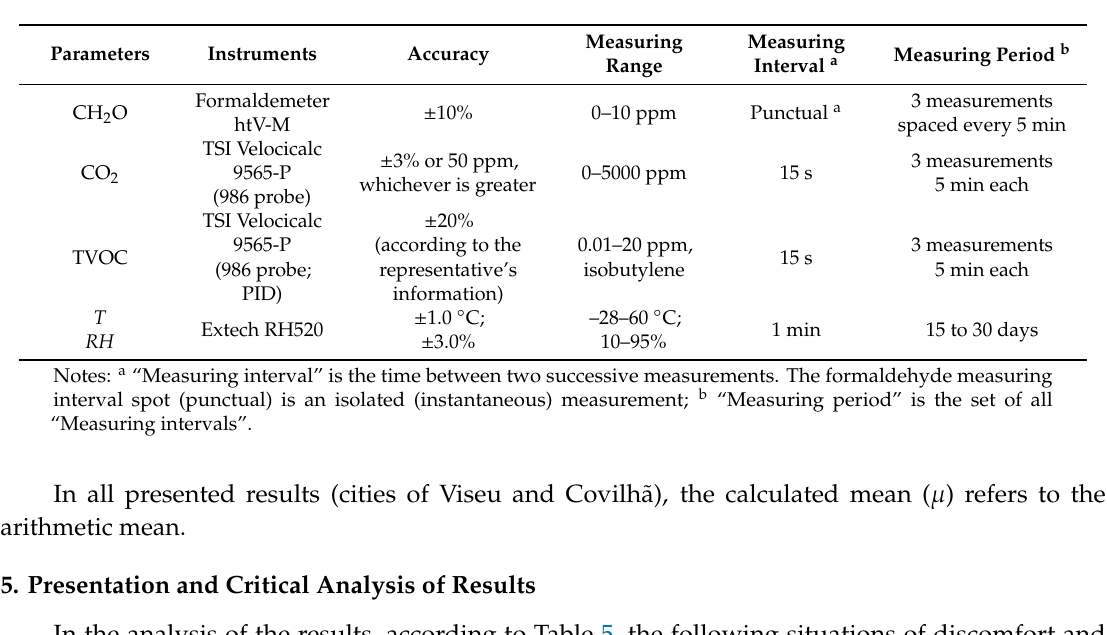
Table 8. Covilh ã : parameters, technical characteristics of the equipment used, and conditions of